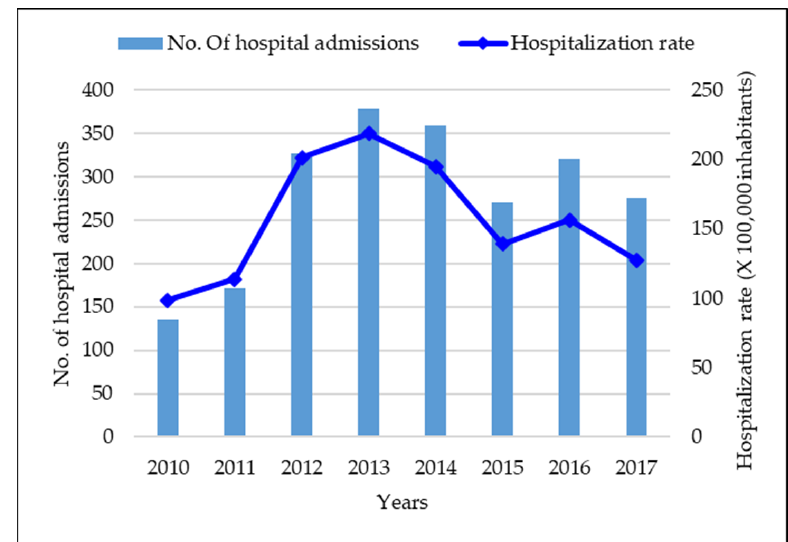
Figure 1. Number of hospitalizations due to varicella and hospitalization rate per 100,000 inhabitants in the Liguria region in Ligurian children aged 0–17 years old.